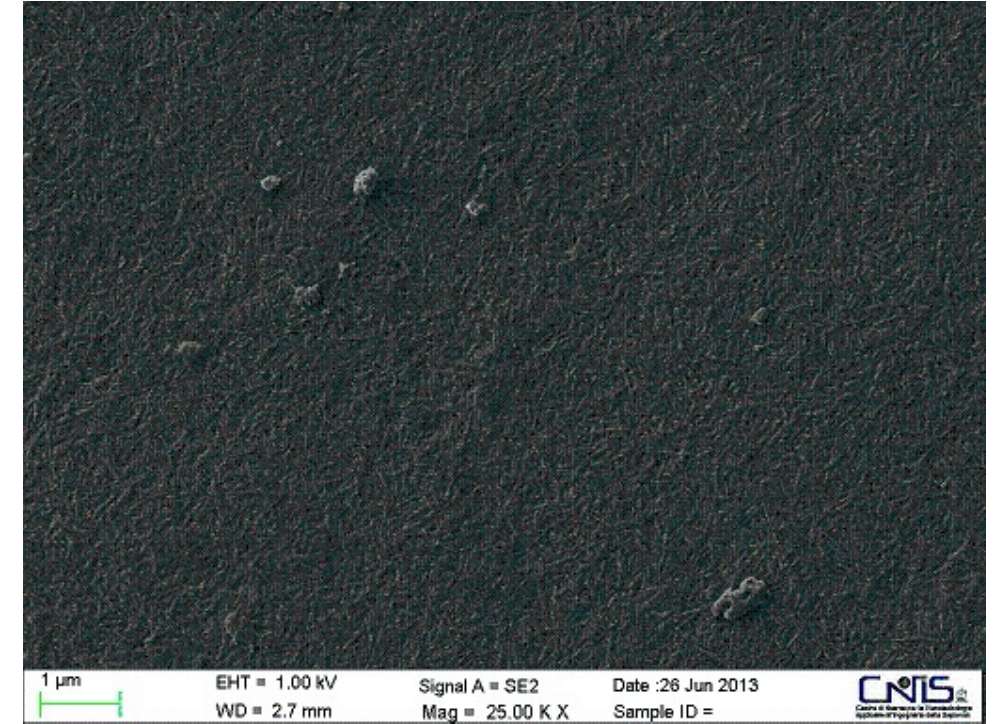
Figure 5. Fibers dimension and interfibrillar boles of a chitin nanofibrils (CN)-film at SEM.